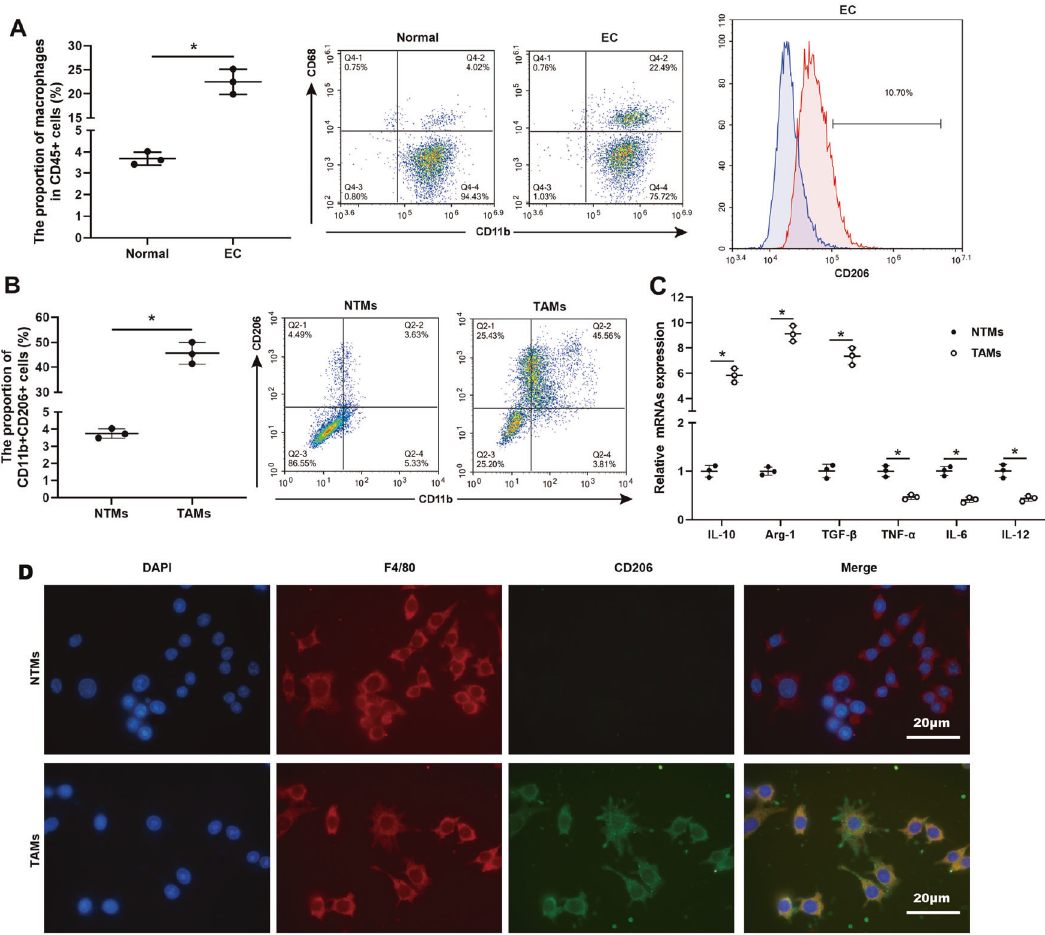
Fig. 1 Accumulation of M2-like TAMs in cancerous tissues of patients with EC. A Flow cytometry analysis and quanti fi cation of macrophages in human EC specimens ( n = 3) and normal endometrial specimens ( n = 3). Left: CD45 + cells were gated and then analyzed the CD11b + CD68 + cells. Right: The proportion of CD206 + cells in human EC specimens. B Flow cytometry analysis and quanti fi cation of CD11b + CD206 + macrophages in tissue-resident macrophages (NTMs, n = 3) and tumor-associated macrophages (TAMs, n = 3). C qRT-PCR analysis of IL-10, arginase-1 (Arg-1), transforming growth factor-beta (TGF- β ), tumor necrosis factor-alpha (TNF- α ), IL-6, and IL-12 mRNA levels in NTMs ( n = 3) and TAMs ( n = 3). * p < 0.05. D The representative images of immuno fl uorescent staining for F4/80 (red) and CD206 (green) performed on TAMs and NTMs. Nuclei were counterstained with DAPI (blue). Scale bar = 20 μ